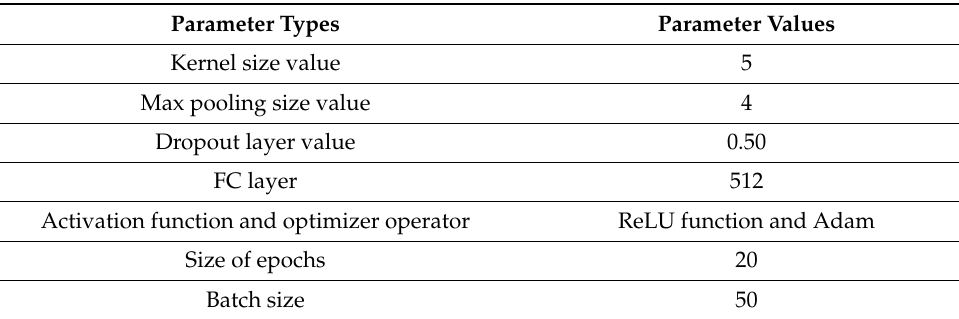
Figure 4. The CNN structure. Table 2. Important parameters of the CNN